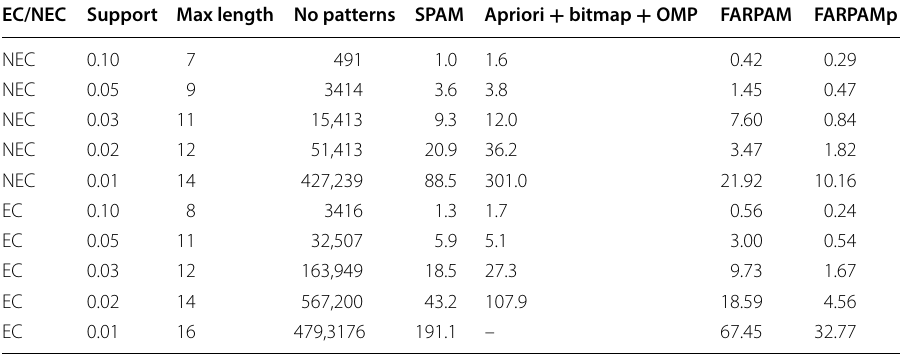
Table 4 Run times (in seconds) for algorithms with zero uncertainty β = 0 for expensive and non-expensive